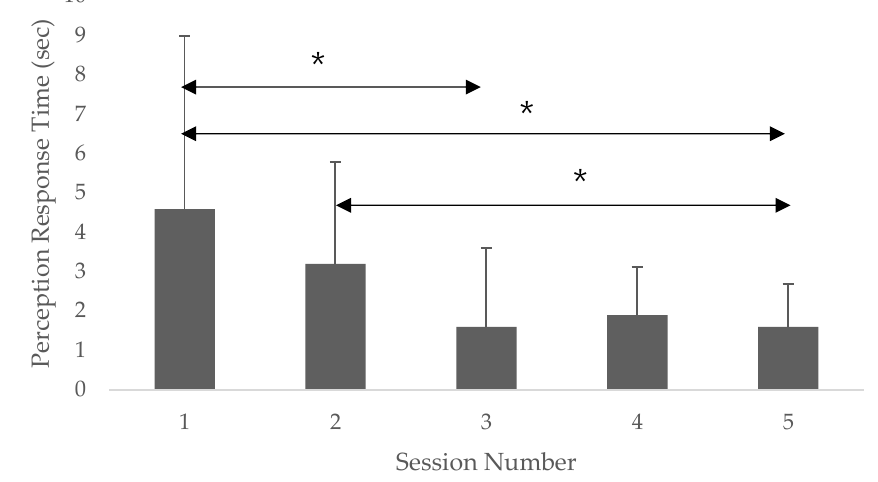
Figure 2. Average perception response time (sec) across time for all participants. * p was significant using the False Detection Rate (FDR) correction rate.